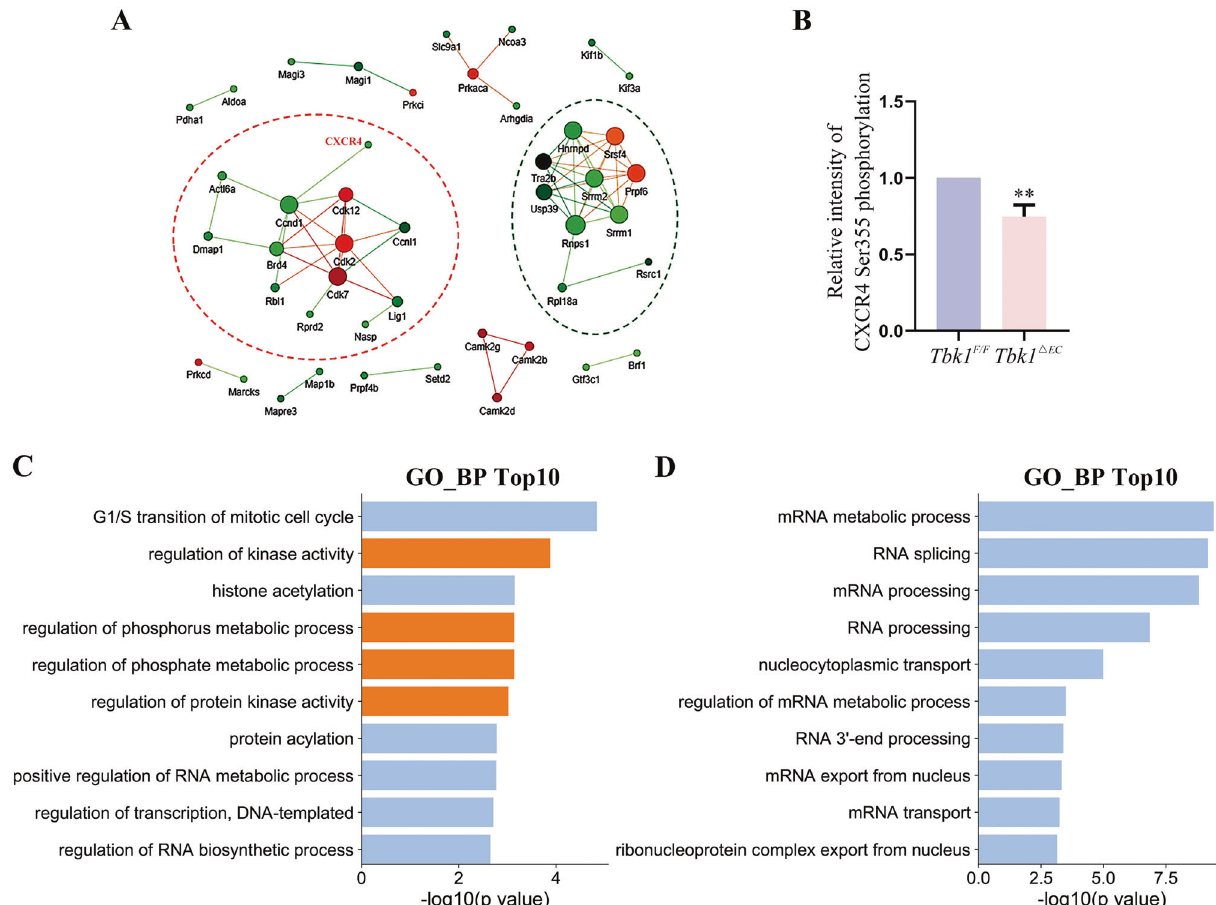
Fig. 4 Bioinformatics analysis of the differentially expressed phosphoproteins. A Interactome of proteins with signi fi cantly different phosphorylation levels in the Tbk1 Δ EC group vs Tbk1 F/F group. Two interaction networks were identi fi ed: Network #1 with a red circle and Network #2 with a green circle. B Relative intensity of CXCR4 Ser355 phosphorylation in Tbk1 F/F and Tbk1 Δ EC retinas. The phosphorylation abundance was normalized with protein expression level. ( n = 3; student ’ s t -test; ** P < 0.01). C Histogram showing the top ten GO items of Network #1 in A from the STRING online database. Orange bars indicated the biological processes associated with CXCR4. D Histogram showing the top ten GO items of Network #2 in A from the STRING online